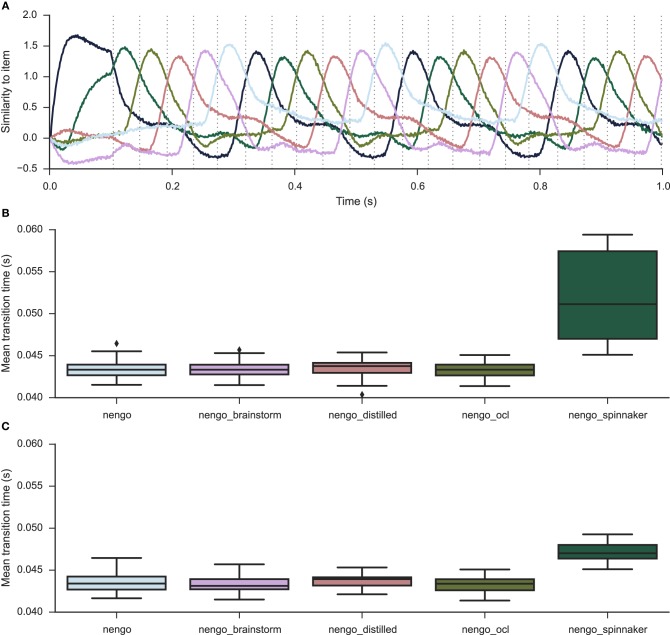
Basal ganglia sequence model. (A) One example instance of the model run on the reference backend; the similarity between the current representation in working memory and the six possible actions is shown (note that in the full benchmark, 10 items are used). The model quickly progresses from one action to the next, cycling back at the end of the six items. The point at which the model switches from selecting one action to another action (the transition times) are indicated with dashed gray lines. (B) The aggregated accuracy results for 50 trials of each backend on the basal ganglia sequence model, with all passthrough nodes included. The observed metric is the mean time to transition from one action to the next. The model is run for 4 s, allowing for approximately 90 transitions, depending on the transition time. The box shows the median and interquartile range, while the whiskers extend to the farthest data point within 1.5 times the interquartile range; outliers are shown above and below the whiskers. (C) The aggregated accuracy results for 50 trials of each backend on the basal ganglia sequence model, with most passthrough nodes pruned. Lines have the same meaning as in (B).